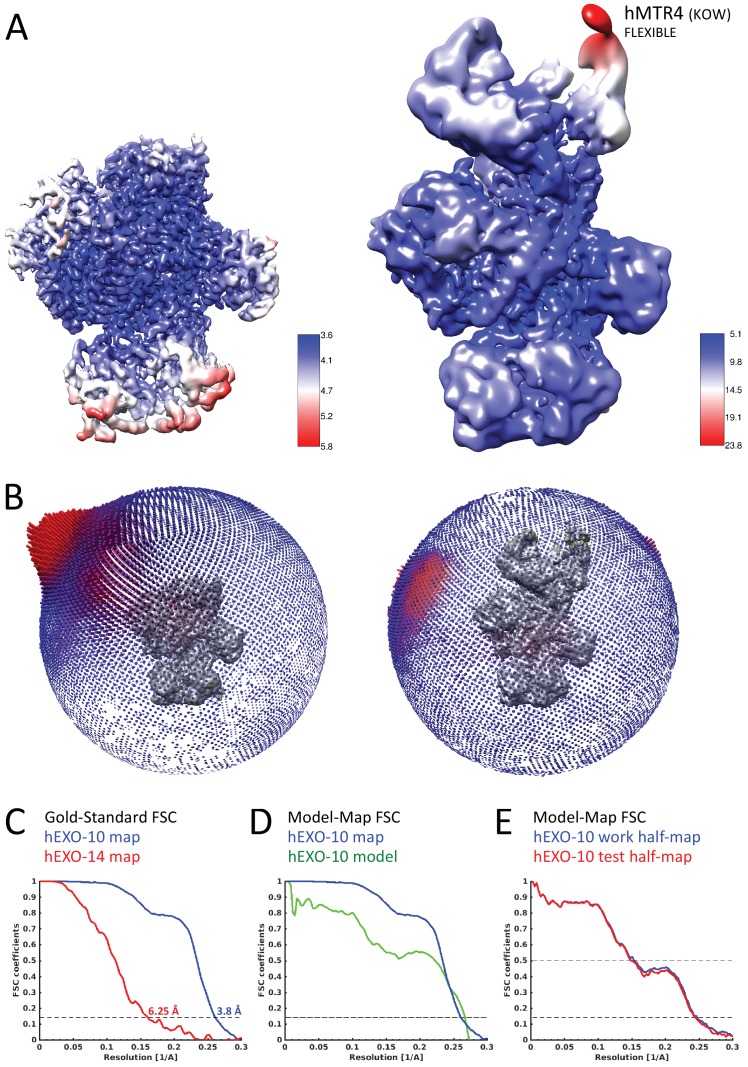
Cryo-EM data quality.(A) Local resolution analysis of both hEXO-10 (left) and hEXO-14 (right). Maps show variation in local resolution, as estimated by RELION. The hEXO-10 map shows high resolution in most of the areas, with the hEXO-9 barrel resolved up to 3.6 Å. Solvent exposed regions of hDIS3 and the hRRP40-hMMP6 interface have lower resolution. The same is true for the hEXO-14 map. The hMTR4 helicase has lower resolution of around 10 Å. The hMTR4 KOW domain is the worst resolved part, most likely due to its flexibility. (B) Angular distribution of the hEXO-10 (left) and the hEXO-14 (right) particles used for the autorefinement. (C) Fourier shell correlation (FSC) curves for the hEXO-10 (blue) and hEXO-14 (red). The gold standard FSC value of 0.143 and resolutions are indicated. (D) FSC from the RELION autorefine procedure (blue) and Model vs. map FSC for the final Phenix real space refined model of the hEXO-10 reconstruction (green). (E) The model was probed for over-fitting by randomly perturbing the atoms by 0.5 Å and refinement against the first of the two independent half-maps (work half-map, blue). The resulting refined model was then used to calculate Model-Map FSCs against the second half-map (test half-map, red) that was not used for refinement. The FSC_work and FSC_test curves show an excellent agreement in the entire resolution range, validating the entire structure for over-fitting.